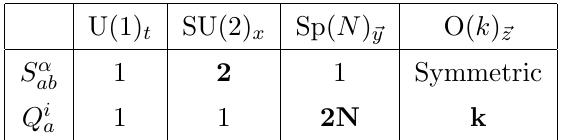
Table 3 . The charges and representations under which the various (cid:12)elds